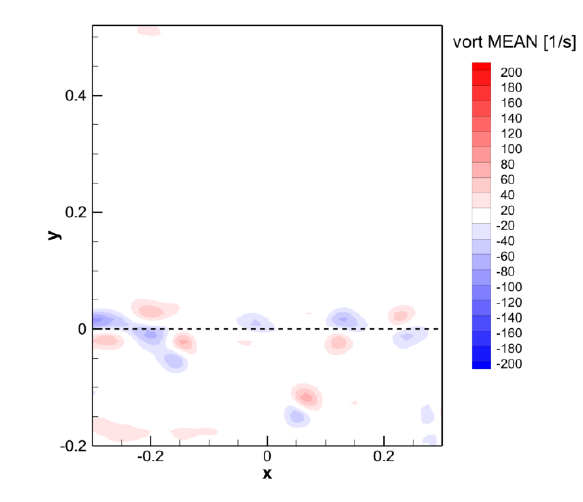
Fig. 7. Mean vorticity distribution. Re = 0.5M.